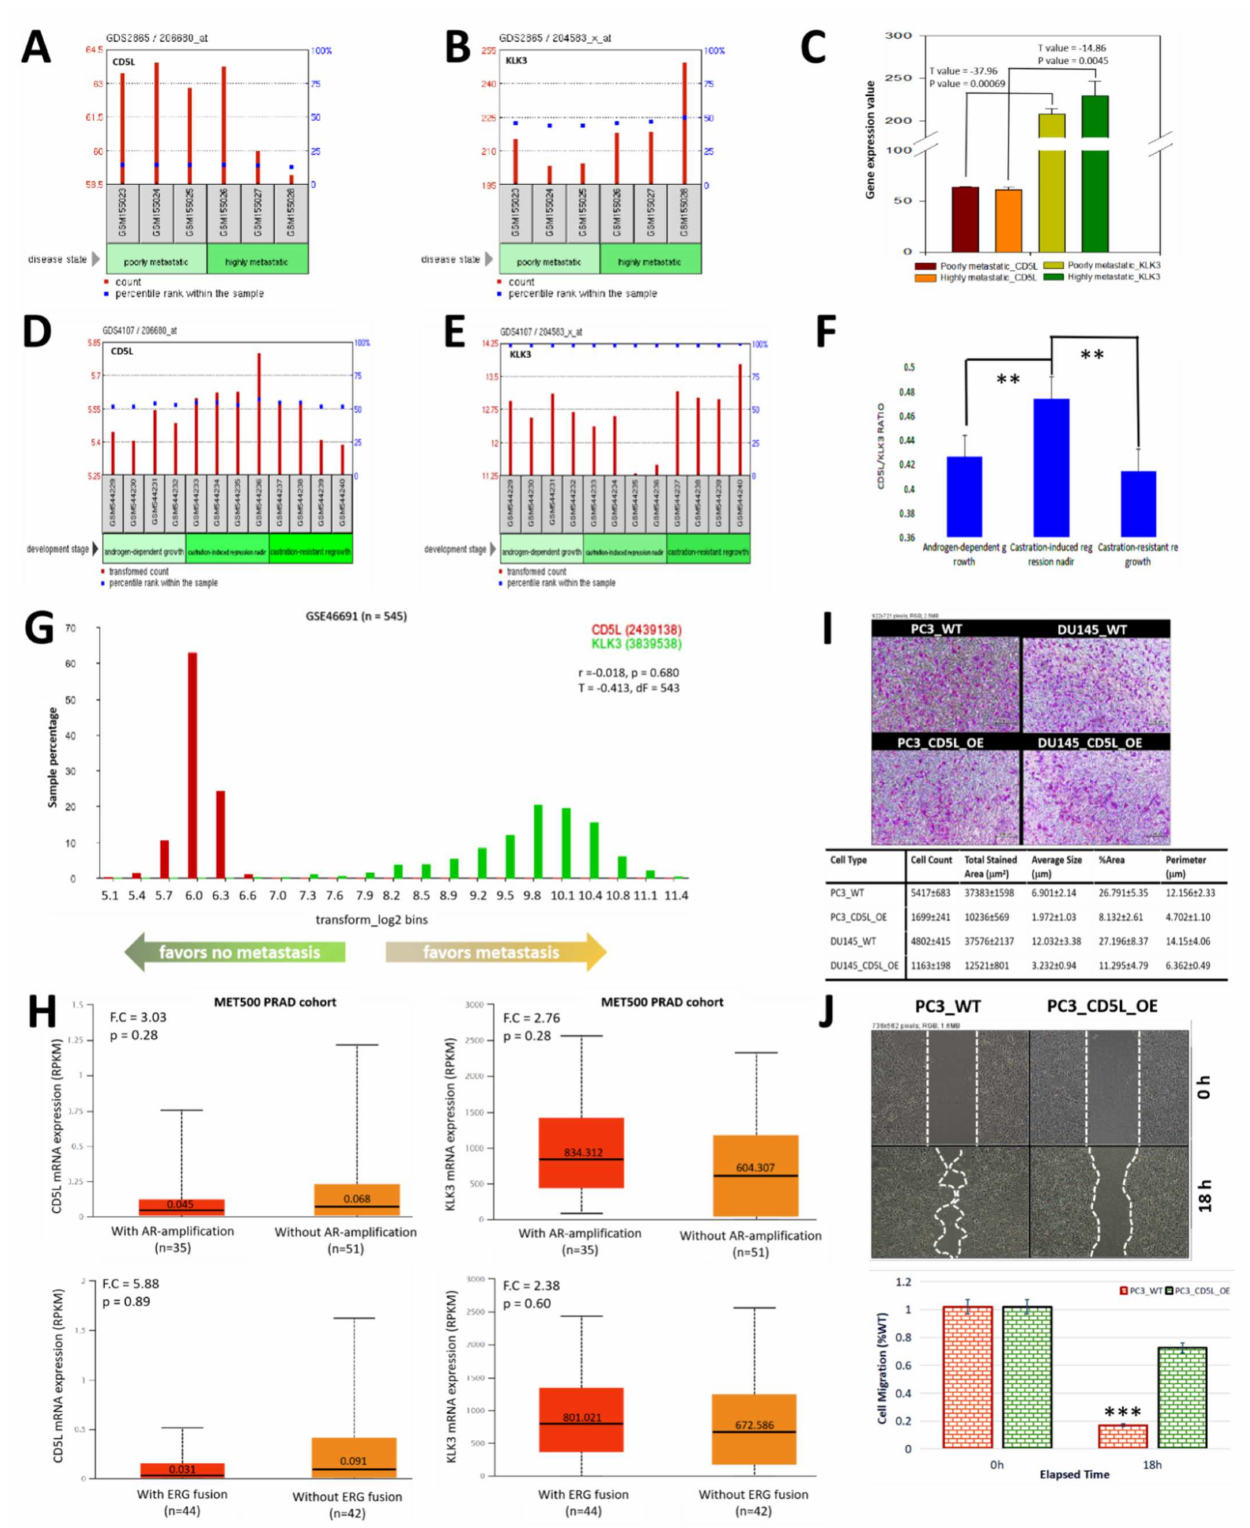
Figure 4. PSA-associated suppression of AIM is implicated in the enhanced metastability of prostate cancer and a high AIM/PSA ratio is associated with strong castration-induced regression. Histograms showing the differential expression of ( A ) cd5l/aim and ( B ) klk3/psa in poorly metastatic or highly metastatic sample from the GDS2865 dataset. ( C ) Histogram comparing the cd5l and klk3 expression values in the poorly or highly metastatic samples from the GDS2865 dataset. Histograms showing the differential expression of ( D ) cd5l/aim and ( E ) klk3/psa in androgen-dependent growth,